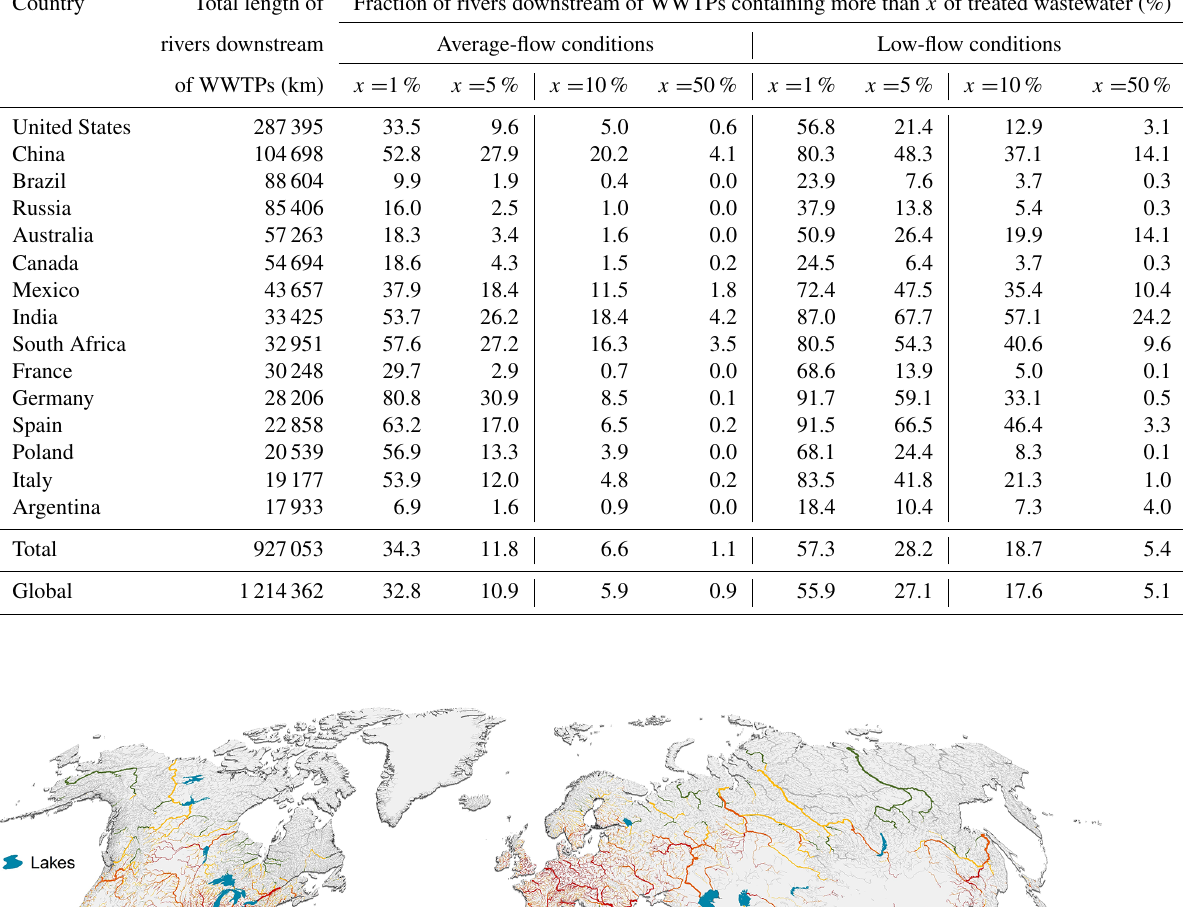
Table 6. Top 15 countries by total length of rivers downstream of WWTPs and percentage of river length exceeding selected treated- wastewater ratios for average and low-flow conditions (for a complete list of countries, see Supplement, Table S6).